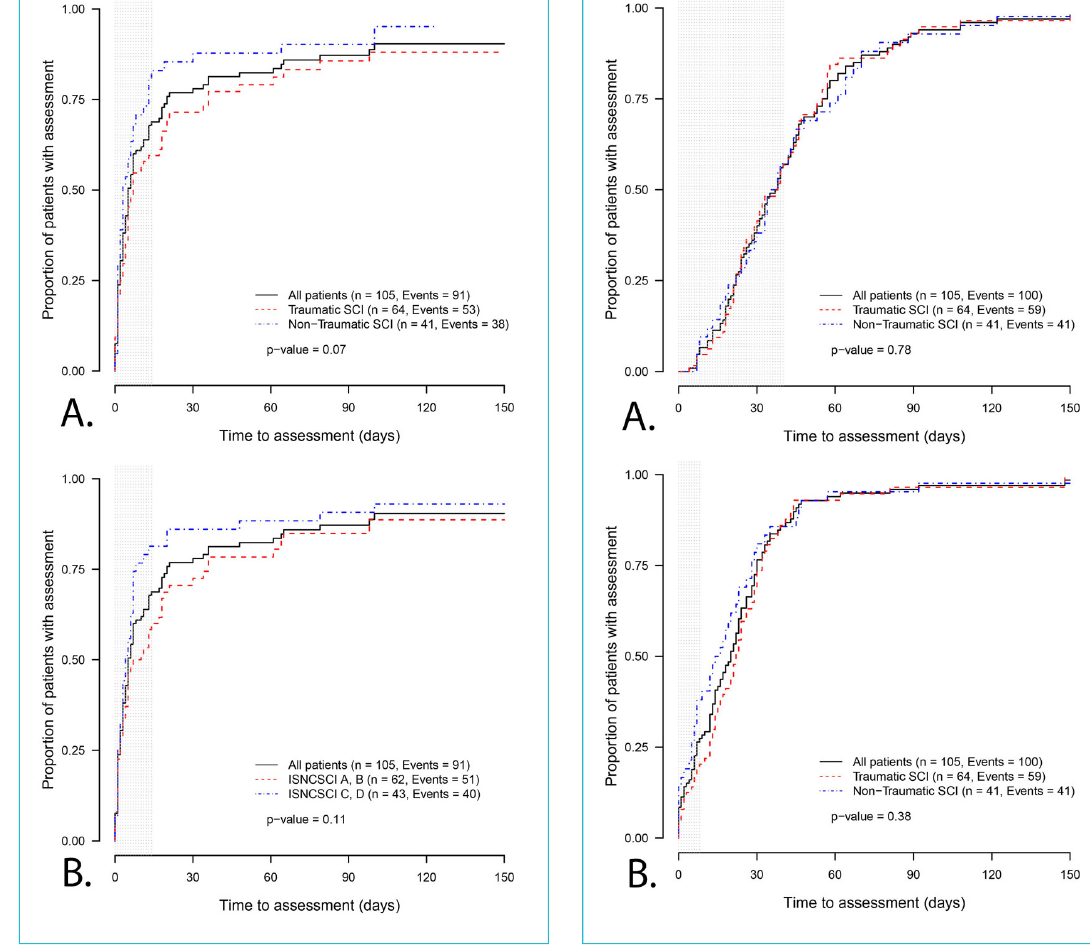
Figure 3: Manual muscle status after hospital admission for pa- tients with a traumatic versus a non-traumatic spinal cord injury (SCI) (A, above), and motor complete versus sensor-motor incom- plete SCI (B, below).The grey shaded area represents the recom- mended time when the assessment should be performed. The black line represents all patients, the coloured lines the respective subgroups.